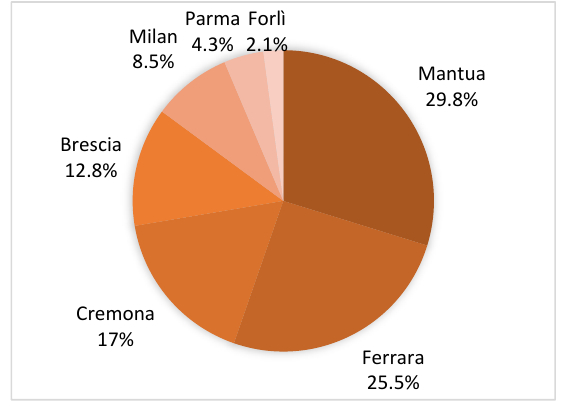
Figure 4. Number of positives, in percentage values, for each province.